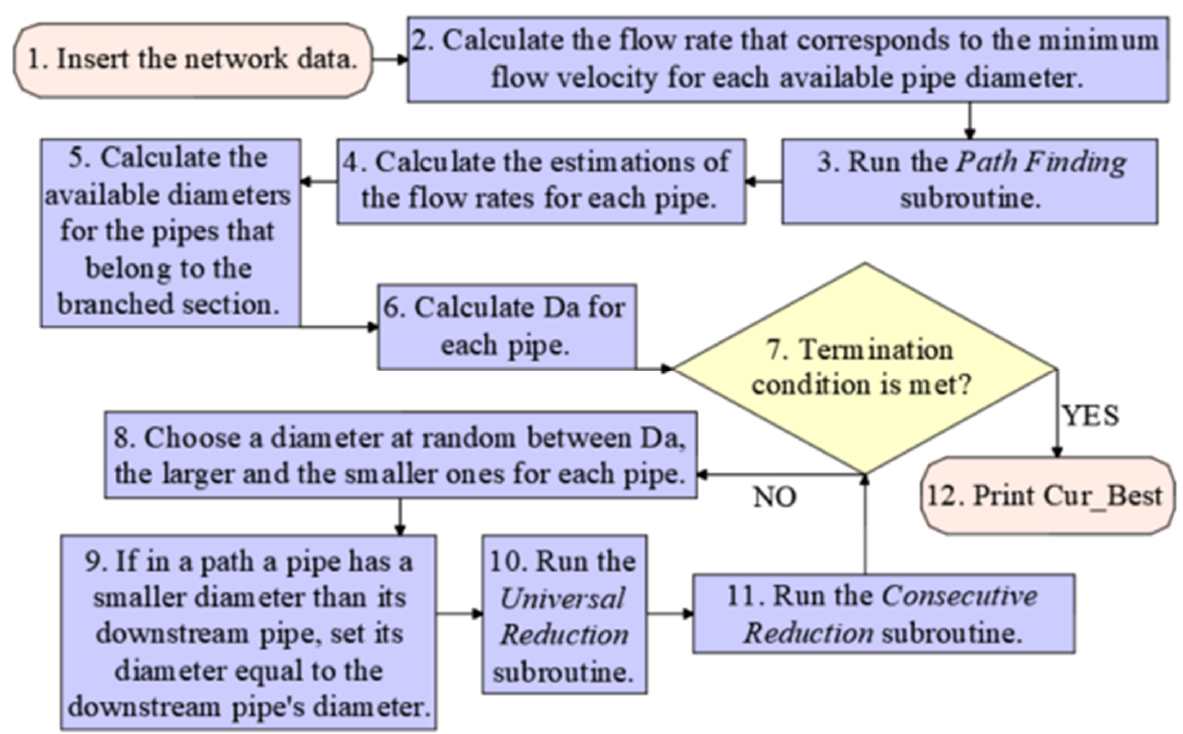
Figure 5. Flowchart of the TPSVR algorithm.